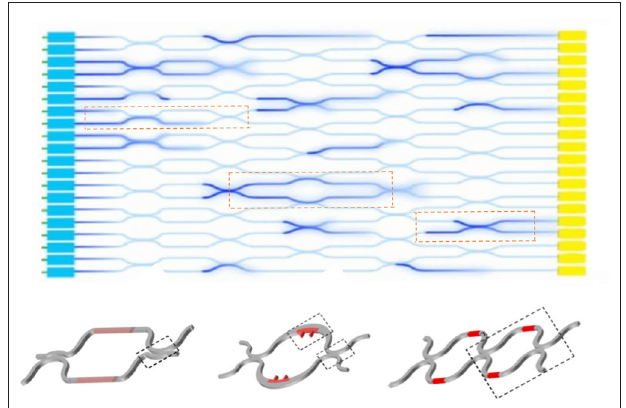
FIGURE 7 | Schematic of various of Mach-Zehnder interferometer (MZI) modulator cells in an optical interferometer. The undesirable attenuation of light in the waveguides and modulators depends on material of the chip platform as well as the dimension and structure of modulators (Stefanov et al., 2020), which determine bending and scattering